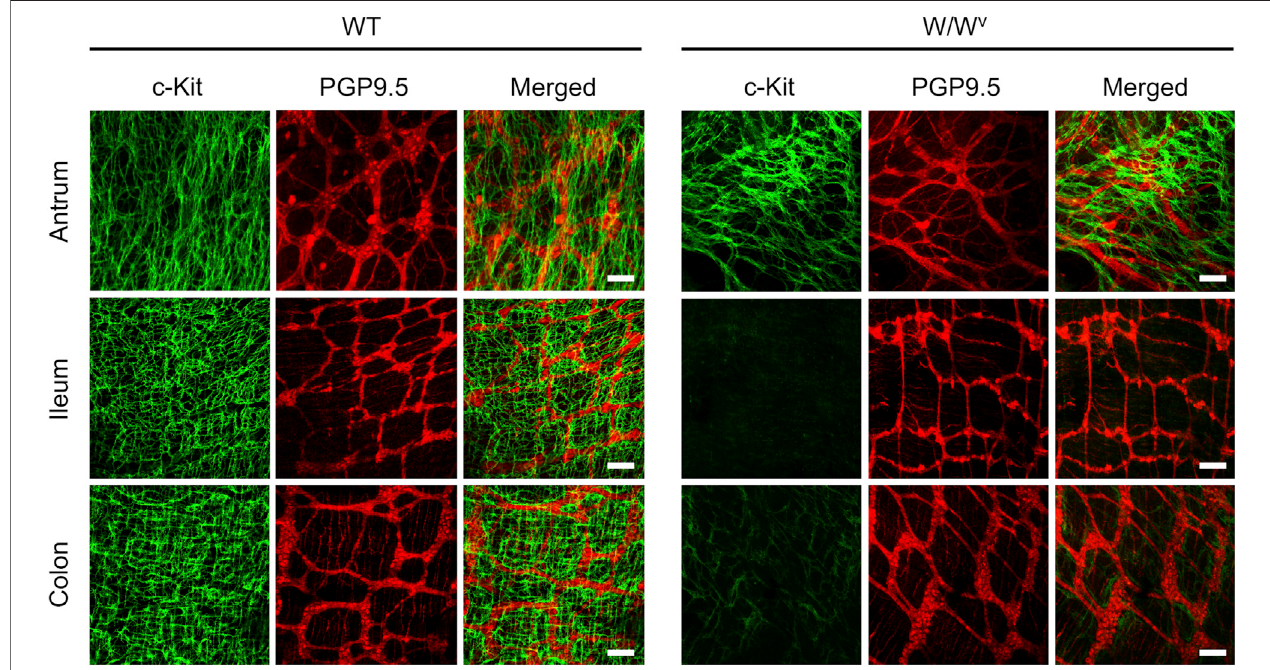
FIGURE 4 | Changes in ICC of the myenteric plexus (ICC-MP) in W / W v mice. These images show representative results of double-immunostaining of c-Kit (ICC marker; green) and PGP9.5 (neuron marker; red) in whole-mount preparations of GI muscularis obtained from WT mice and W / W v mice. In the tissues ofWT mice, ICC- MP expressing c-Kit (green) were located in the same area where is the myenteric plexus (red). In W / W v mice, ICC-MP were maintained only in the antrum and absent in the ileum and colon. Merged images are a combination of green and red color images. Scale bar, 100 μ m.